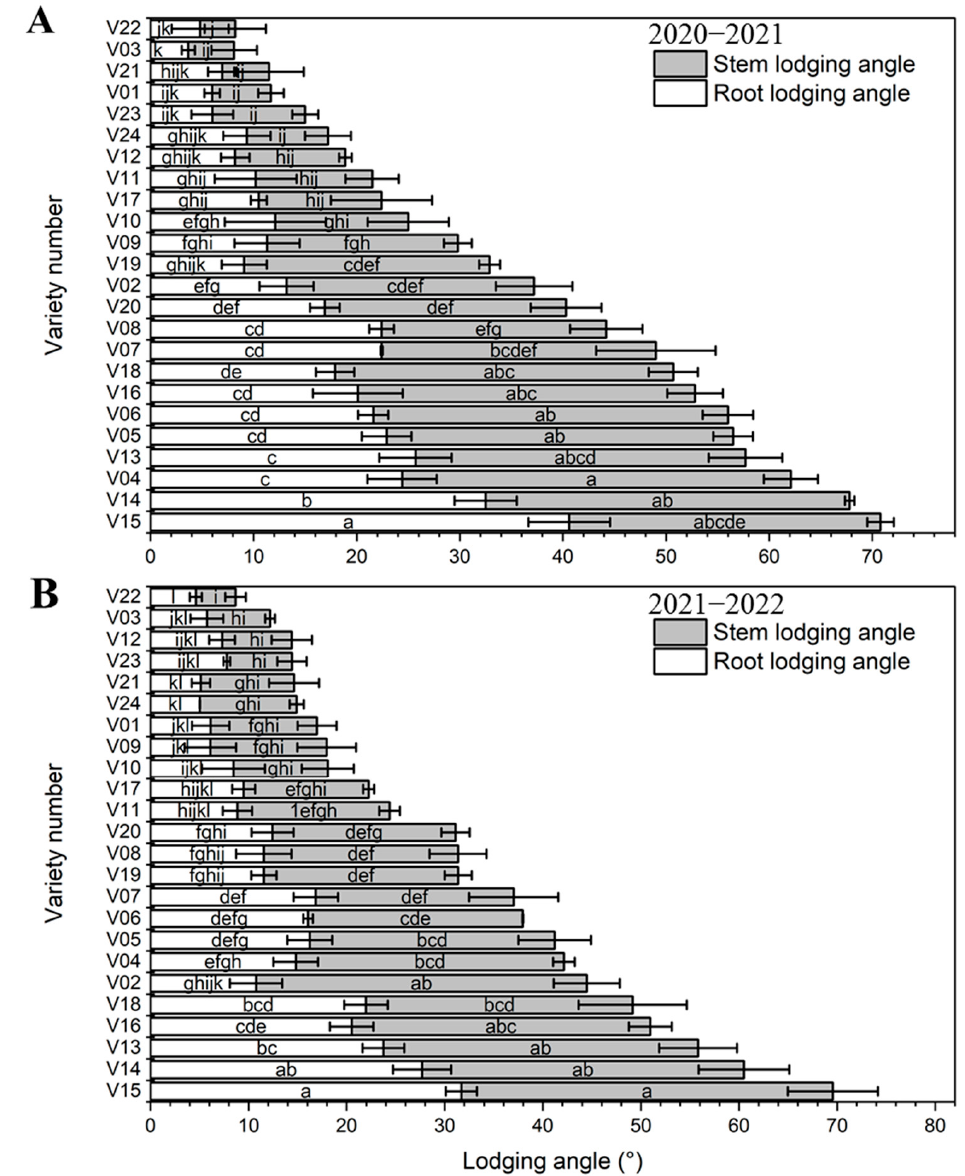
Figure 6. Root and stem lodging angles of the 24 rapeseed varieties for the growing seasons 2020–2021 ( A ) and 2021–2022 ( B ). Different lowercase letters in the bar indicate significant difference at the 5% level.